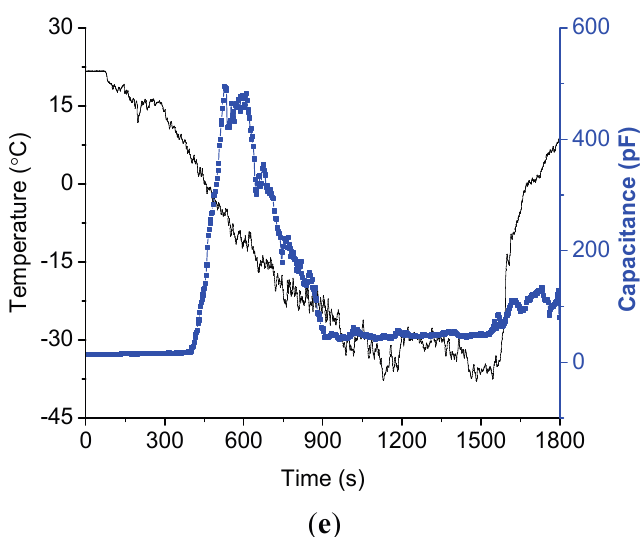
Figure 10. Real time measurement of ice growth for the different relative humidity: ( a ) at a relative humidity of 30%; ( b ) at a relative humidity of 35%; ( c ) at a relative humidity of 44%; ( d ) at a relative humidity of 52%; ( e ) at a relative humidity of